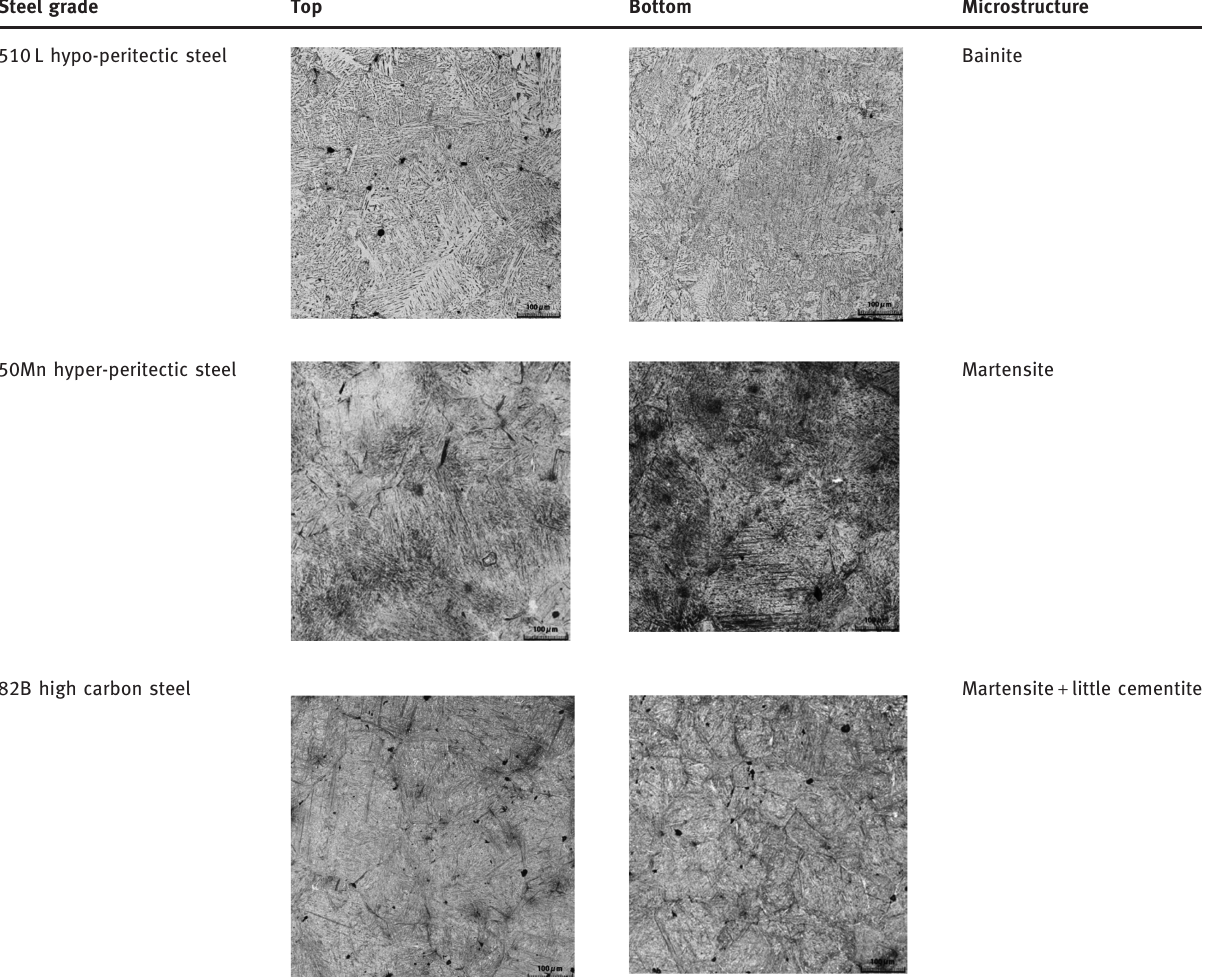
Table 2: Metallographic graphs of center section of solidified shell of various steels (4% nitric acid alcohol erosion). Steel